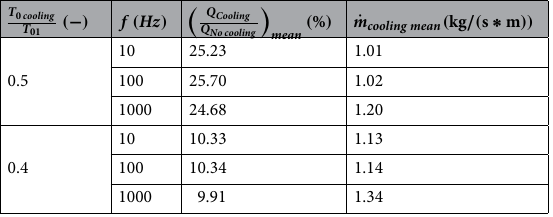
Table 7. Thermal load alleviation summary for unsteady cooling